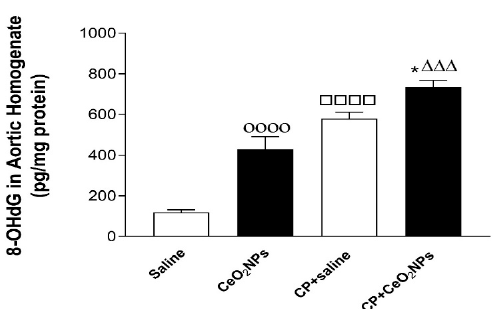
Figure 6. Aortic homogenates concentration of 8-hydroxy-2-deoxyguanosine (8-OH-dG) in rats intratracheally instilled with either saline ( n = 6) or CeO2 NPs ( n = 6) with ( n = 5) or without ( n = 6) CP administration. * P < 0.05 compared with CP + saline-treated group. ΔΔΔ P < 0.001 compared with CeO 2 NPs-treated group. □□□□ P < 0.0001 compared with saline-treated group. οοοο P < 0.0001 compared with saline-treated group. Data are mean ± SEM.